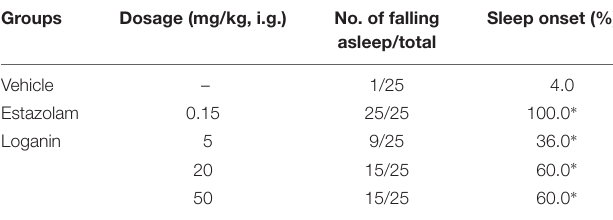
TABLE 1 | Effect of loganin on sleep onset of mice induced by subhypnotic dosage of pentobarbital. Groups Dosage (mg/kg,